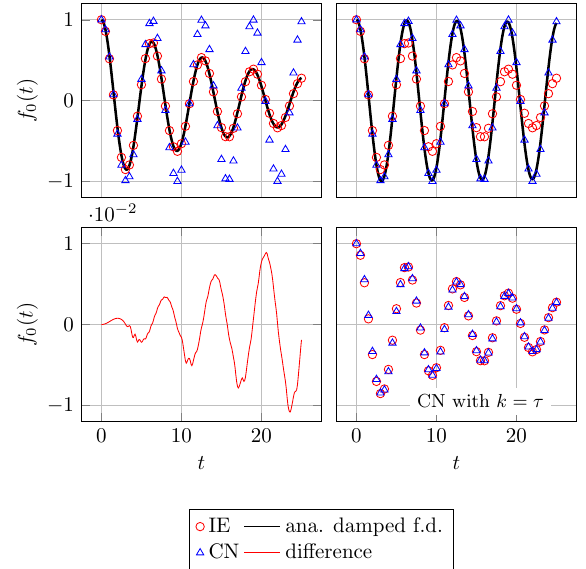
Figure 5. For all plots, red circles indicate the CN method, and the blue triangle denotes the SO l 0 scheme. The black solid line indicates the analytical damped feature descriptor, and the red line stands for the difference between the two analytical damped feature descriptors obtained from the second-order methods. ( Top left ) The damping parameter for the analytical damped feature descriptor was set to k = τ /2. ( Top right ) Damping parameter was set to k = τ /8. ( Bottom left ) We plotted the difference between the analytical damped feature descriptors obtained with the CN and SO l 0 method. The difference will not exceed 1 10 − 2 . Therefore, only CN is used as a representative ± · of the second-order methods. ( Bottom right ) We compared the damped feature descriptor ( k = τ ) obtained using the CN method with the feature descriptor using IE. All (damped) feature descriptors are extracted from a solution u ( x , t ) at the point x = 0. For the numerical calculations, we set the time increment τ = 0.1 and the lattice parameter to h = 0.05.